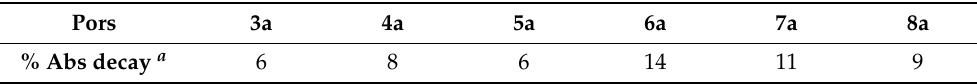
Table 2. Photostability of Pors 3a – 8a in PBS after 60 min of white light irradiation at an irradiance of 50 mW cm − 2 . Pors % Abs decay a a Measured at Soret band